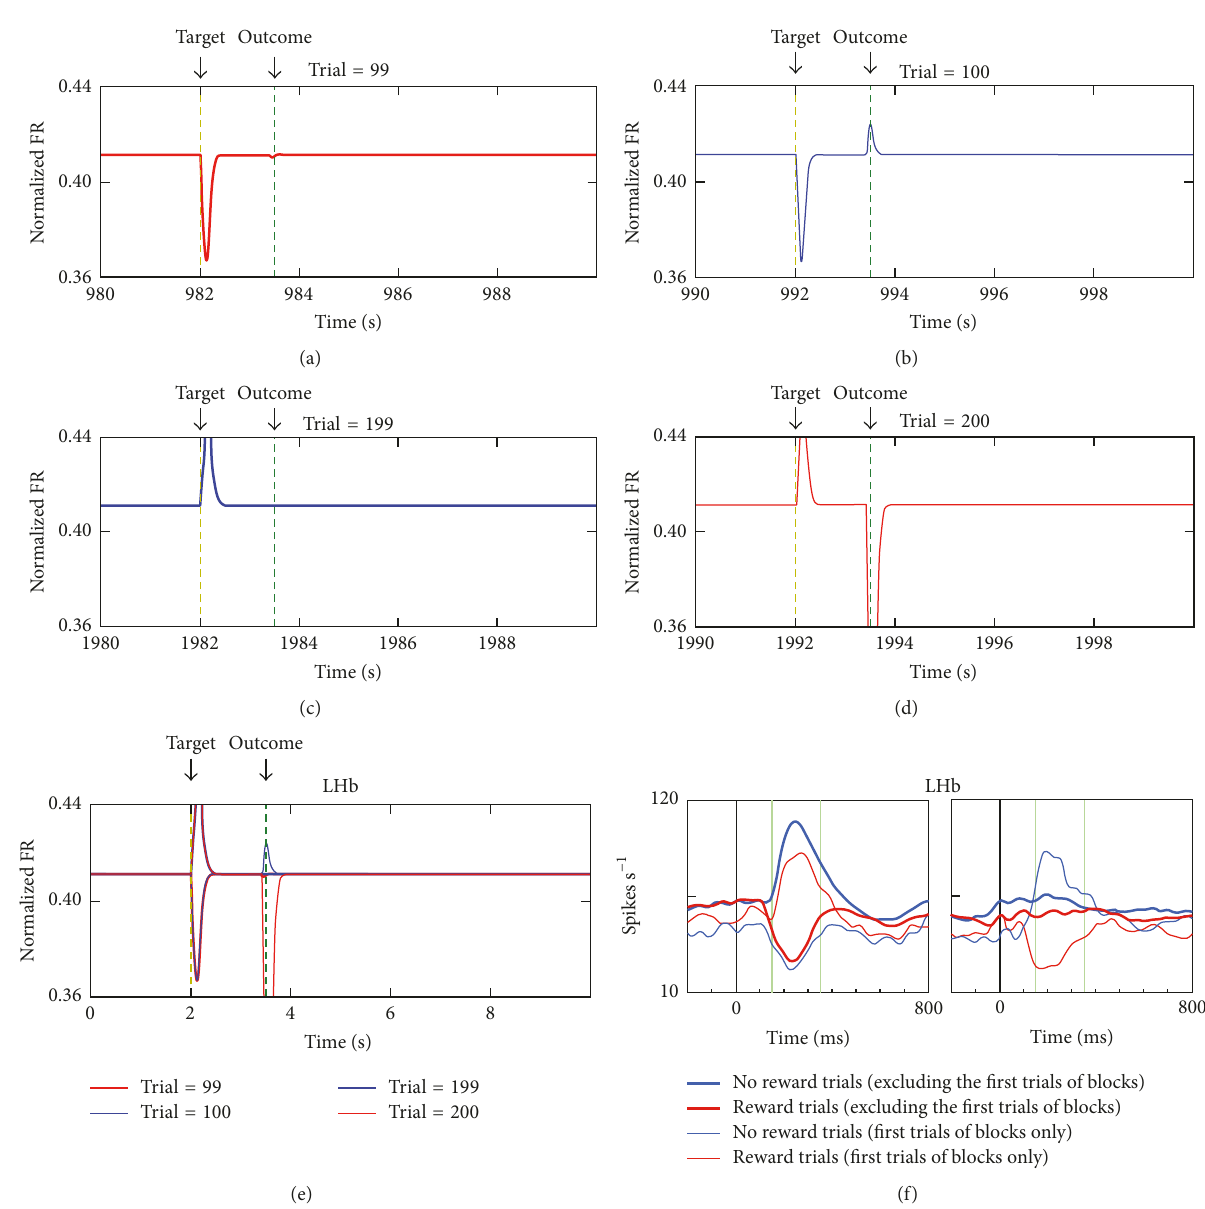
Figure 6: Acquired response of LHb neurons. (a) The 99th trial: from the 1st trial to the 99th trial, the model circuit receives rewarding CS and rewarding US. The result shows that, after learning, LHb neurons exhibit a phasic dip upon rewarding CS and a baseline activity in response to rewarding outcome. (b) The 100th trial: the model circuit receives rewarding CS and nonrewarding US. The result shows that LHb neurons exhibit a phasic dip when rewarding CS appears and exhibit a phasic peak at the time when the reward should be released. (c) The 199th trial: from the 101st trial to the 199th trial, the model circuit receives nonrewarding CS and nonrewarding US. The result shows that, after learning, LHb neurons exhibit a phasic peak upon nonrewarding CS and a baseline activity due to omission of reward at this trial. (d) The 200th trial: the model circuit receives nonrewarding CS and rewarding US. The result shows that LHb neurons exhibit a phasic peak when nonrewarding CS appears and exhibit a phasic dip upon rewarding US. (e) The phasic activity of LHb neurons under different situations. The thick red line indicates the activity of LHb at the 99th trial, the narrow blue line indicates the activity of LHb at the 100th trial, the thick blue line indicates the activity of LHb at the 199th trial, and the narrow red line indicates the activities of LHb at the 200th trial. The yellow dashed line indicates the time at which CS appears and the green dashed line indicates the time at which rewards are released or not. (f) The physiological experimental results reprinted from Hong and Hikosaka [2]. Red lines indicate reward trials, and blue lines indicate no reward trials. Thick lines indicate reward CS-to-reward US (red) and nonreward CS-to-nonreward US (blue), while narrow lines indicate reward CS-to-nonreward US (blue) and nonreward CS-to-reward US